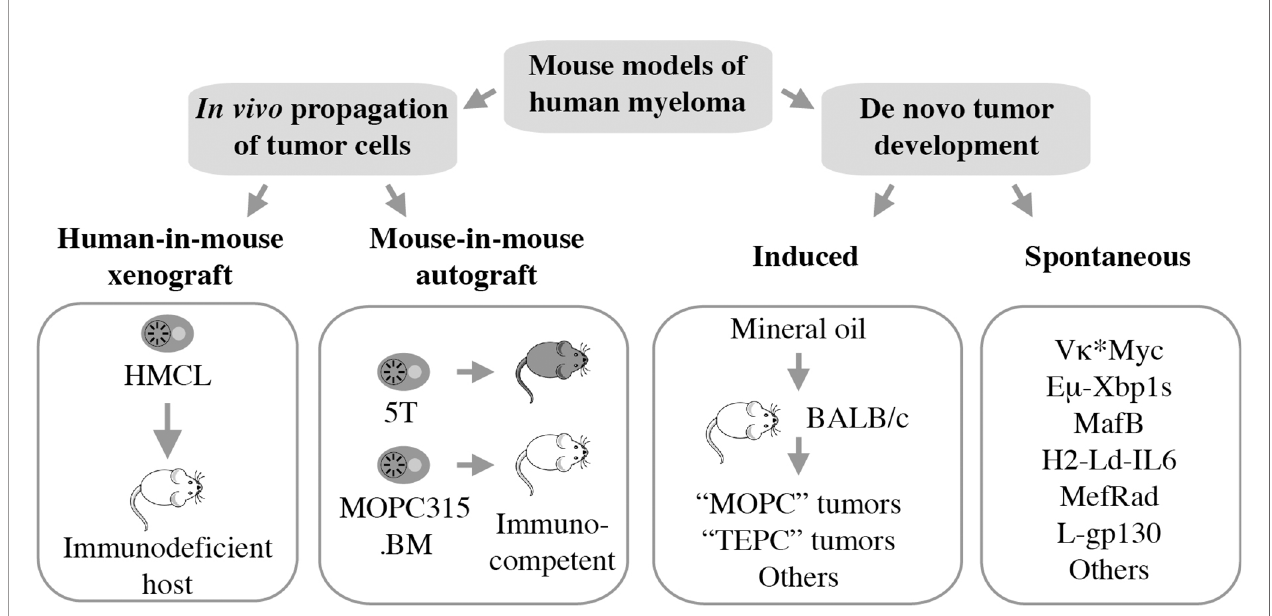
FIGURE 1 | Mouse models of human myeloma. Xeno- and autografting relies on in vivo propagation of fully transformed tumor cells. Models of tumor development include peritoneal plasmacytomas that can be readily induced in genetically susceptible BALB/c mice and myeloma-like tumors that arise spontaneously in a variety of transgenic